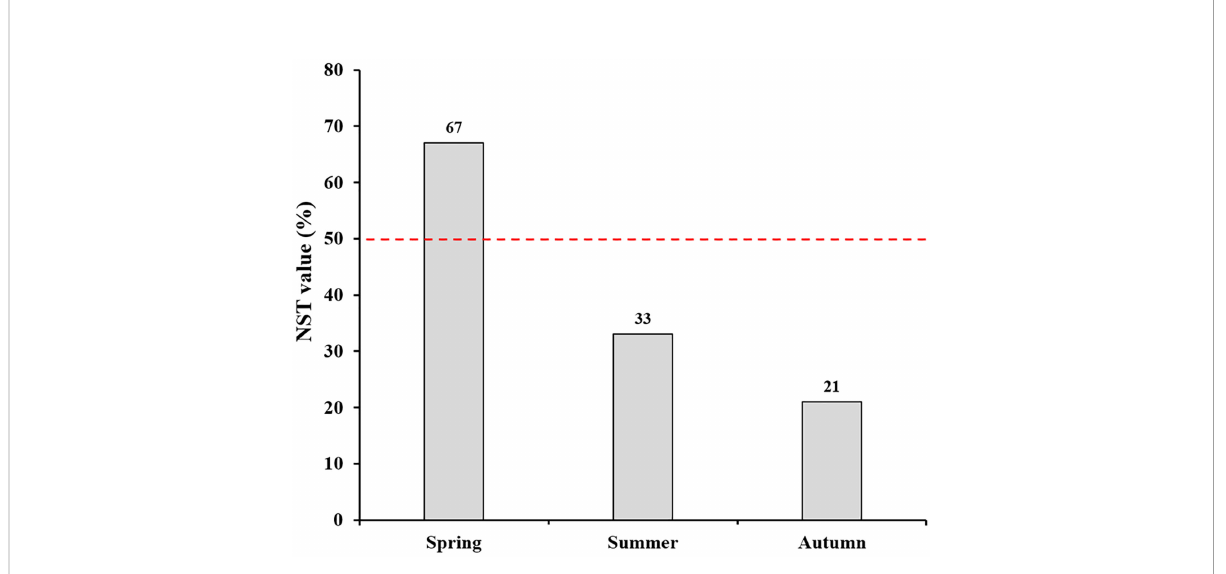
FIGURE 7 Normalized stochasticity ratio (NST) showing community assembly pattern of root-associated fungi of P. mongolica across three consecutive